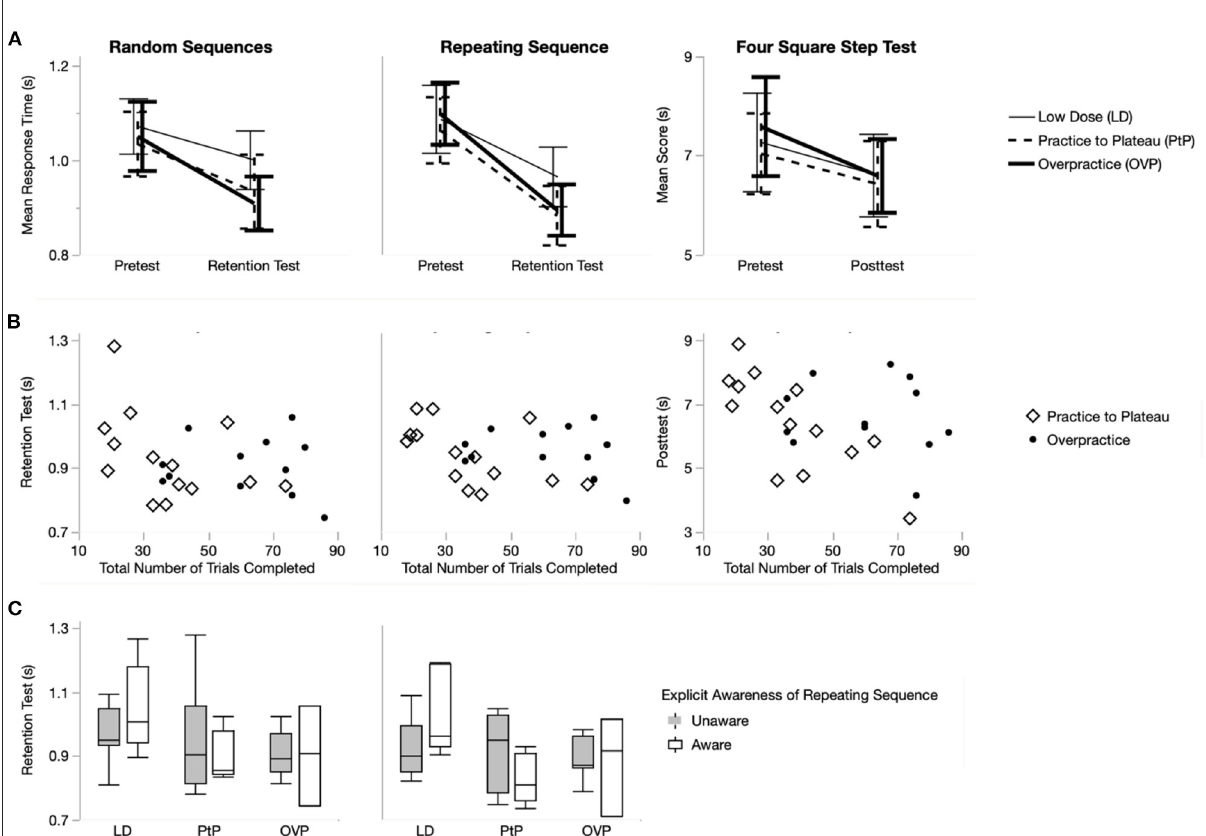
FIGURE4 Each column is titled to indicate the dependent variable to which its figures correspond: Random Sequences (i.e., general learning), Repeating Sequence (i.e., repeated-sequence learning), and Four Square Step Test (i.e., transfer of learning). Row (A) shows the main effect of time for each of the dependent variables. Each plot shows mean response time (for the Serial Reaction Time Task) or mean time (for Four Square Step Test) at pretest and at retention test or posttest for each of the groups: LD (thin solid line), PtP (medium dashed line), and OVP (thick solid line). Error bars represent 95% confidence intervals. Row (B) shows separate scatterplots for each of the dependent variables. Each plot shows retention or posttest times as a function of the total number of trials of the practiced Serial Reaction Time Task for the two groups included in this analysis (note that the LD group is not included): PtP (open diamond) and OVP (solid circle). Row (C) shows box plots illustrating learning (at retention test) of the two serial reaction time task dependent variables: random sequences and repeating sequence. Each plot shows retention as a function of whether or not the participant became explicitly aware of the imbedded repeating sequence, and includes all three groups: LD, PtP, and OVP. LD, Low Dose group; PtP, Practice to Plateau group; OVP, Overpractice group.